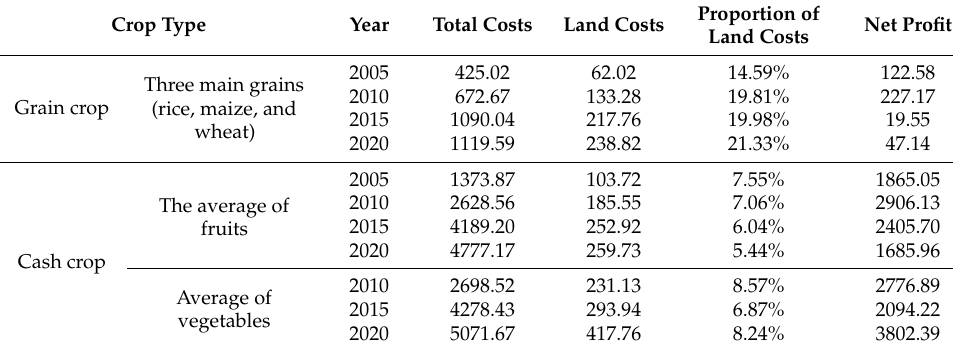
Table 1. Costs and profits of main crops in China unit: yuan/mu,